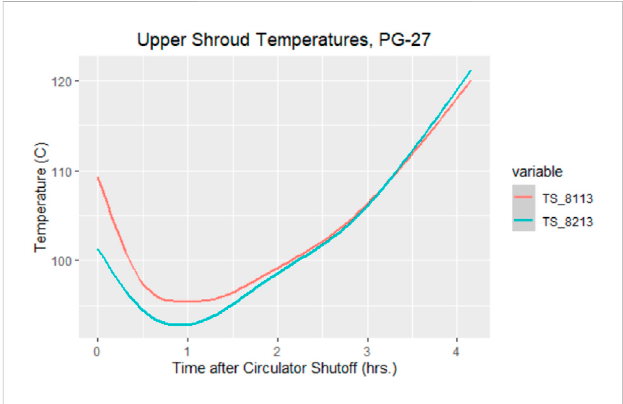
FIGURE 8 Upper plenum shroud temperatures during